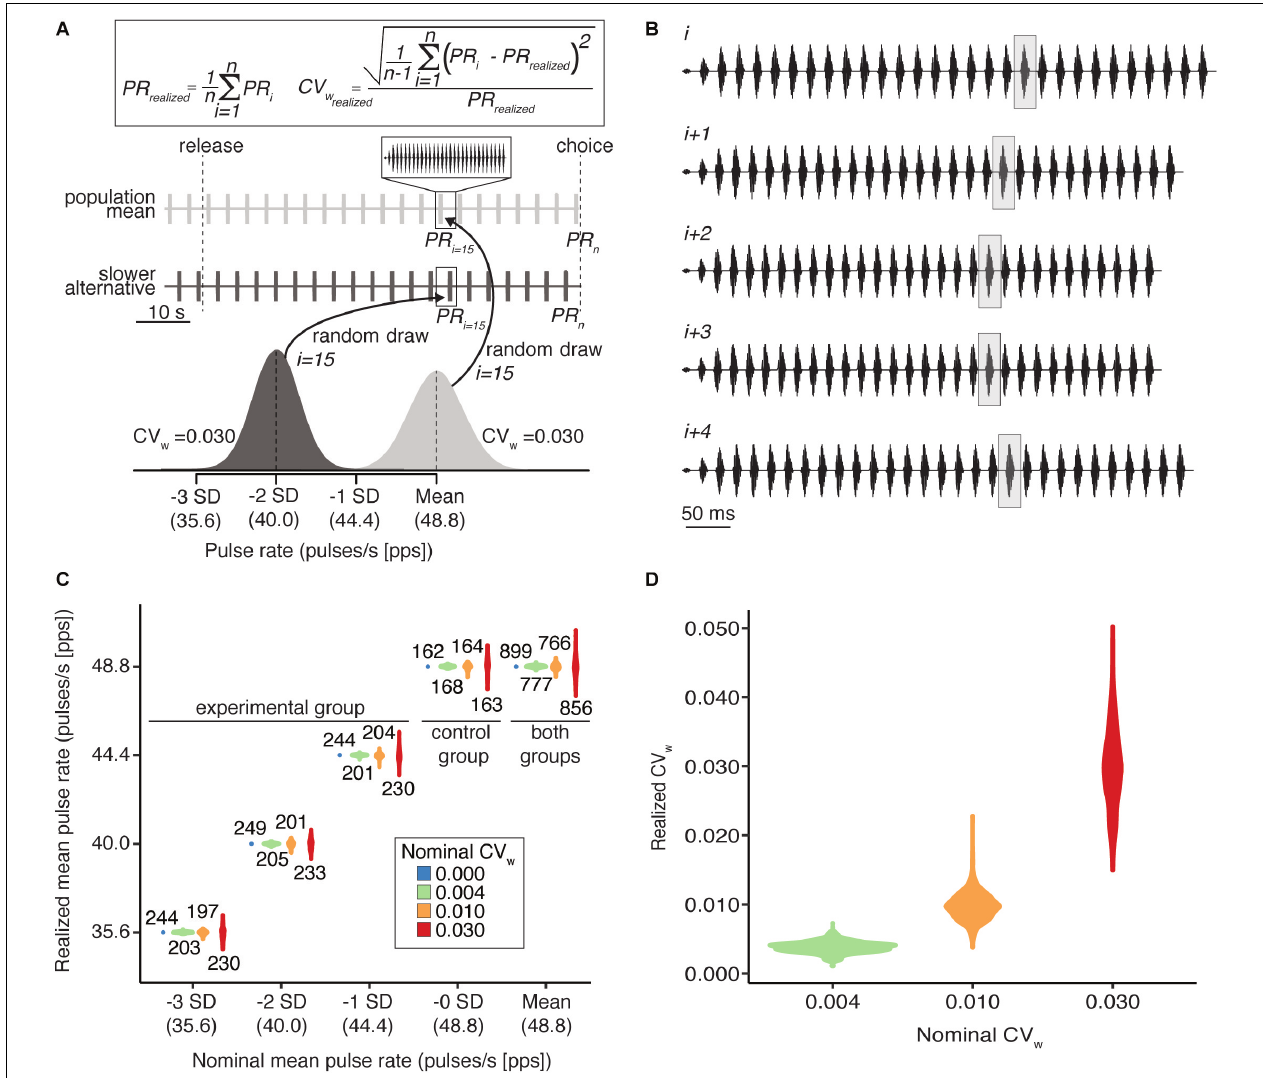
FIGURE 1 | Relationships between realized and nominal trait values in experimental stimuli. Nominal values represent experimentally specified levels while realized values reflect averages among the stimuli that were heard by the subject in each trial. The trait values of individual calls in stimuli with higher assigned CV w were drawn from broader distributions, making these stimuli more variable. (A) Random draws from normal distributions representing the population mean (light gray) and –2 SD (dark gray) distributions used to generate two alternative signal sequences (waveforms) for a single behavioral trial. Equations (top) demonstrate the computation of realized mean pulse rate and realized CV w for a given sequence. (B) Waveforms of five representative calls with randomly drawn pulse rates ( i to i + 4) from a representative stimulus sequence whose nominal mean pulse rate was 0 SD (48.8 pps) in the CV w = 0.030 inconsistency level. The 20th pulse in each call is highlighted in gray to aid in visualizing the variable pulse rate across calls. (C) Violin plots show the distributions of realized alternative pulse rates in experimental stimuli grouped by nominal mean pulse rate. Subjects assigned to the experimental group were given a choice between a stimulus whose nominal mean pulse rate matched the population mean of 48.8 pps (Mean) and an alternative stimulus with a nominally slower pulse rate (i.e., Mean versus –3, –2, or –1 SD ). Subjects assigned to the control group were given a choice between two equivalent stimuli whose nominal mean pulse rates matched the population mean (i.e., Mean versus –0 SD ). Text annotations show the sample size, in number of tests, at each combination of nominal mean pulse rate and coefficient of variation within stimuli (CV w ). Because in each test subjects across both groups chose between a stimulus with a mean pulse rate (Mean) and one whose pulse rate was –3, –2, –1, or –0 SD from the mean, the sample sizes of the Mean alternative are necessarily sums of the other four tests performed at the same nominal level of within-individual variation. (D) Distributions of realized CV w across three nominal levels of within-individual variation. Invariant stimuli necessarily have a realized CV w of 0 and are not depicted in (D) . In both panels (C,D) , colors represent nominal levels of within-individual